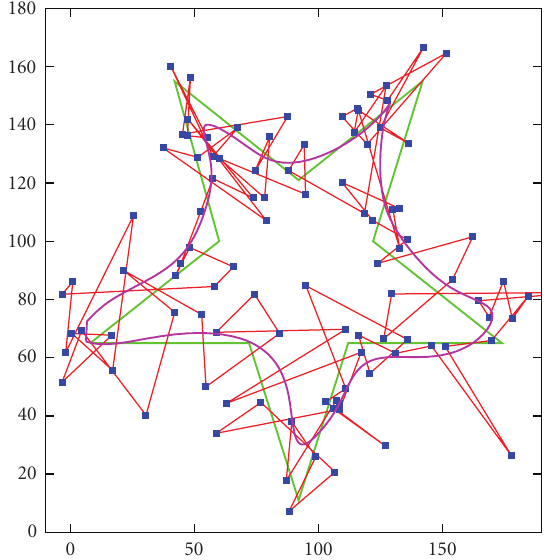
Figure 6: Recovery of the boundary of the star specified by 100 points with Gaussian noise of ν = 8 as in Figure 5. The boundary is constructed using approximate interpolation with σ A = 1 × 10 − 6 and σ B = 2 × 10 − 4 . The recovered curve is shown as a thicker line.